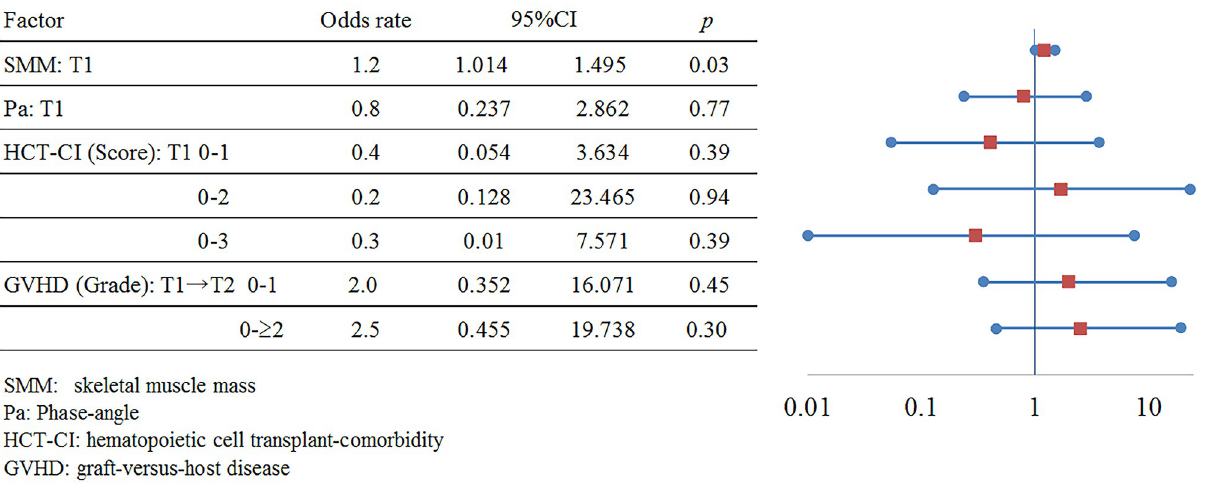
Fig 6. Association between two-year survival, mortality, and clinical indicators.